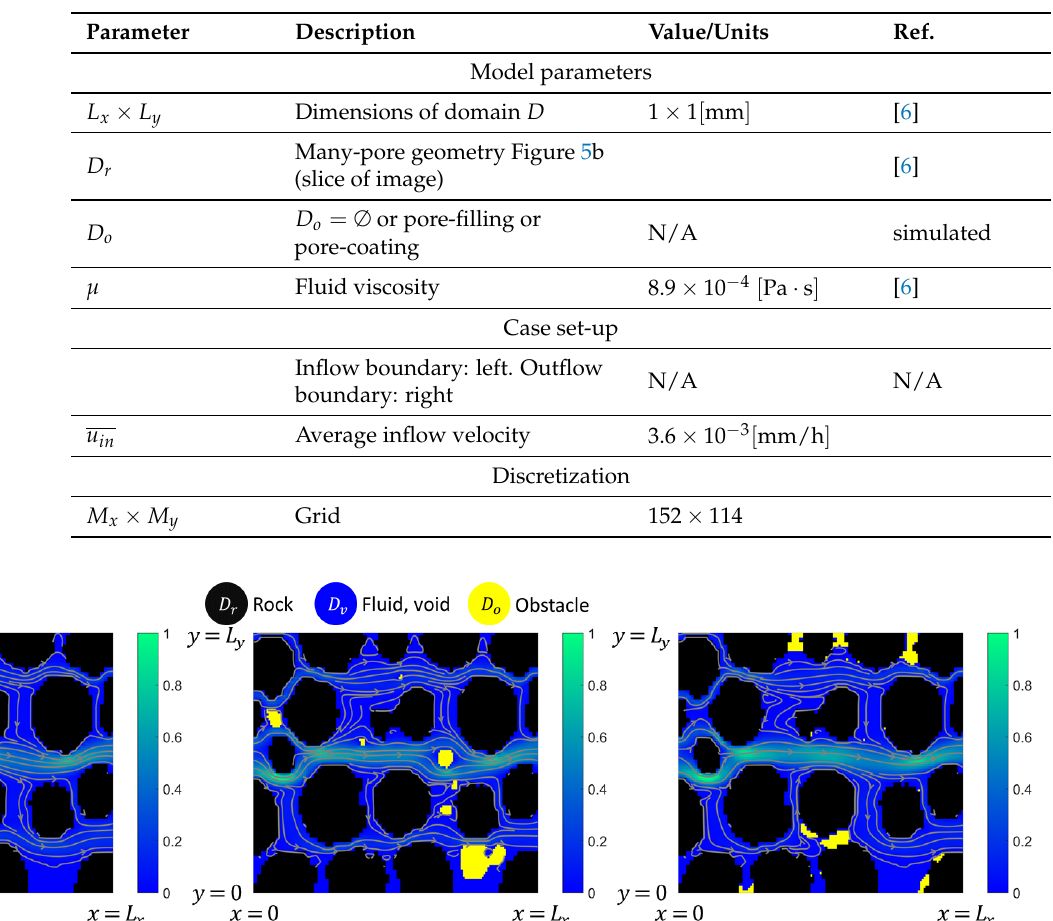
Table 1. Parameters for the flow example in Example 1.